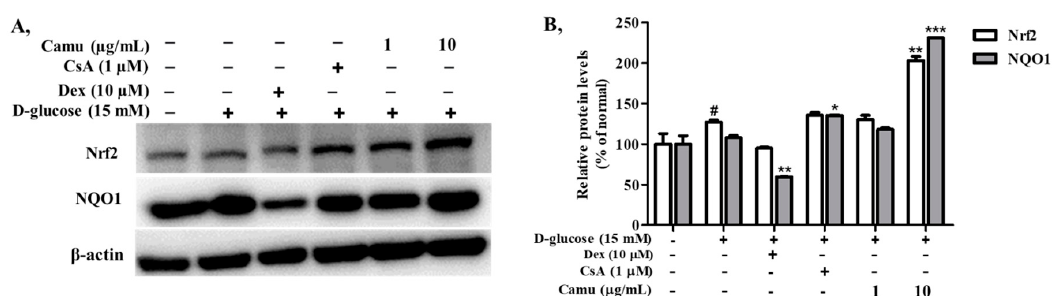
Figure 7. Regulatory effects of the camu-camu fruit extract on the Nrf2/ARE pathway in high glucose-stimulated HaCaT cells were assessed by Western blot analysis ( A ) and band intensities for Nrf2 and NQO-1 were quantified by densitometry and normalized; the percentage was calculated on the basis of the level of β‐ actin ( B ). The data are shown as the means ± SD of at least two independent experiments. # Significant differences between the untreated group and the high glucose ‐ induced group (# p < 0.05) * Significant differences between the high glucose ‐ induced group and the other groups (* p < 0.05; ** p < 0.01; *** p < 0.001).